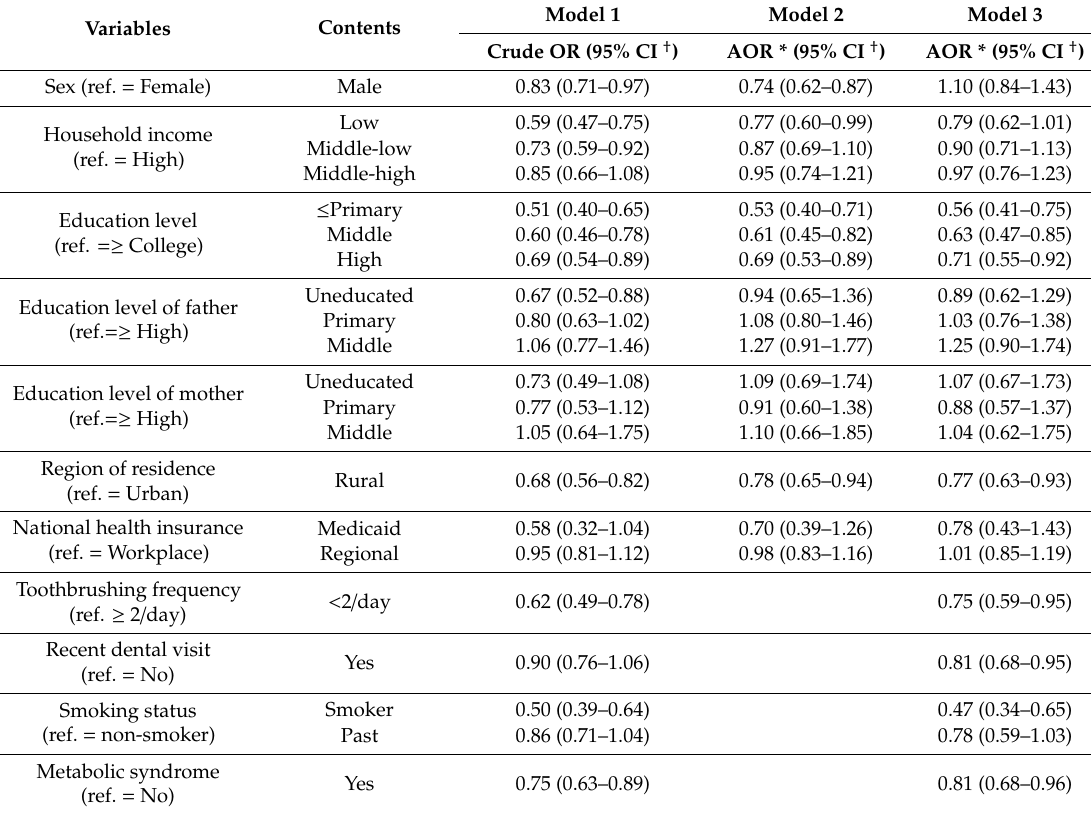
Table 5. The adjusted association of the median number of existing teeth with variables related to the demographic socioeconomic status, oral health-related behaviours, and metabolic syndrome among all participants aged 55–79